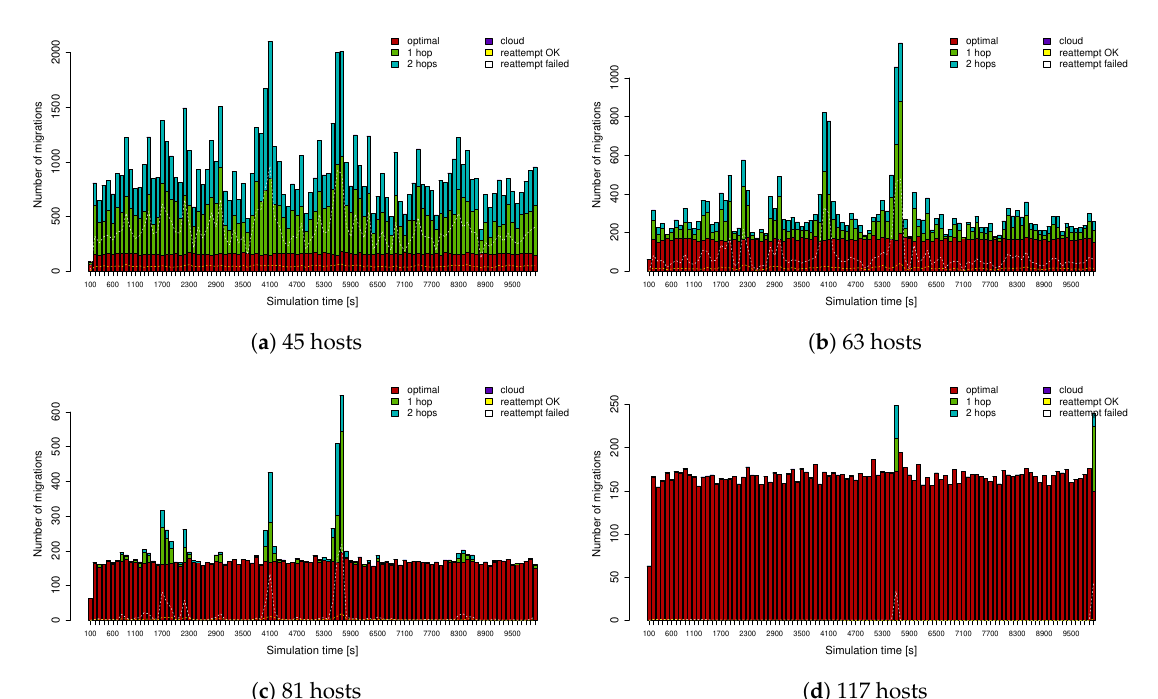
Figure 6. Number of migrations of edge services considering their distance to the MEC host that is providing the